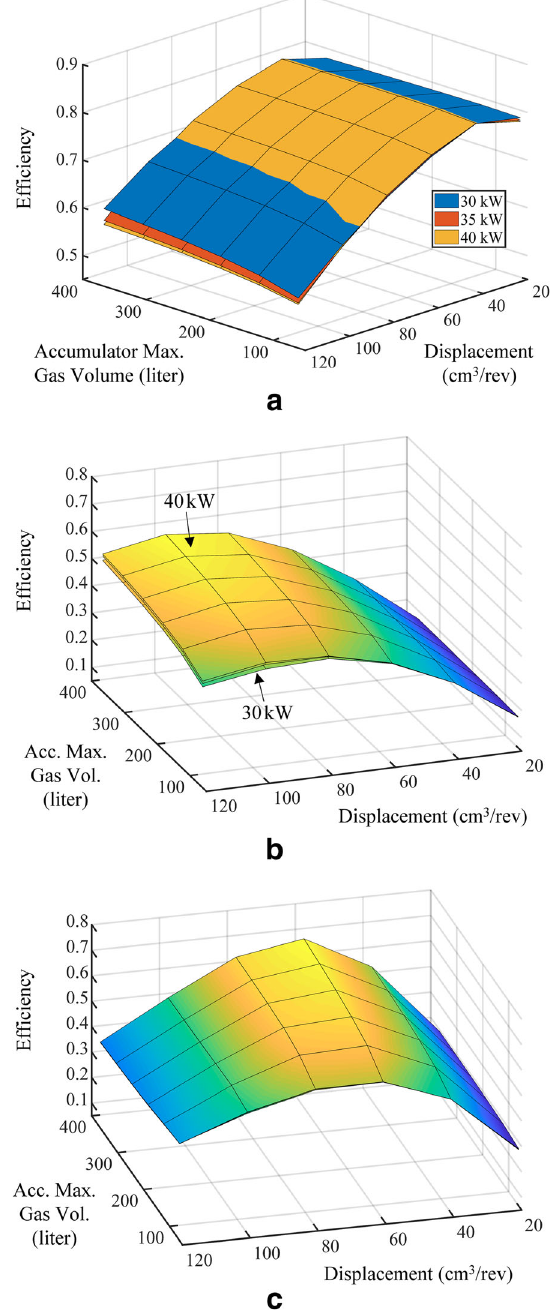
Fig. 6 System energy efficiency at 21 MPa system pressure with different generator power ratings. a HESC system efficiency at sea state 3. b Whole system efficiency at sea state 3. c Whole system efficiency at sea state